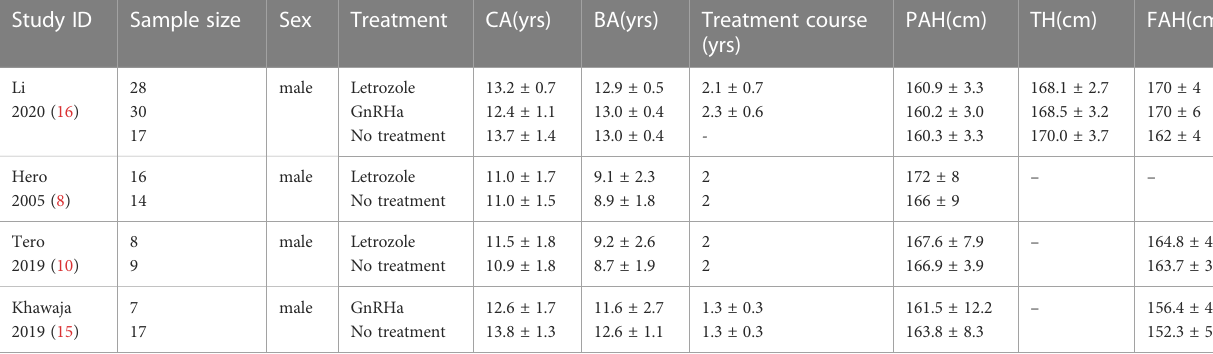
TABLE 1 Characteristics of included studies in this meta-analysis. Study